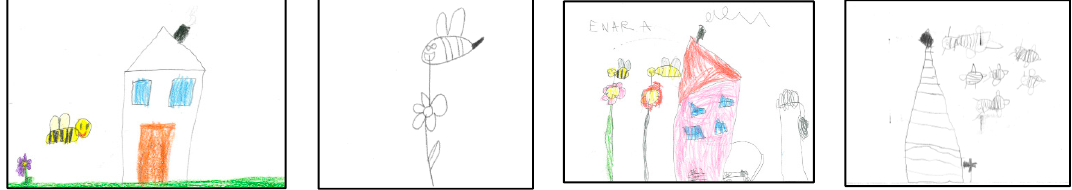
Figure 1. A sample of drawings with more than one element made by five and six-year-old